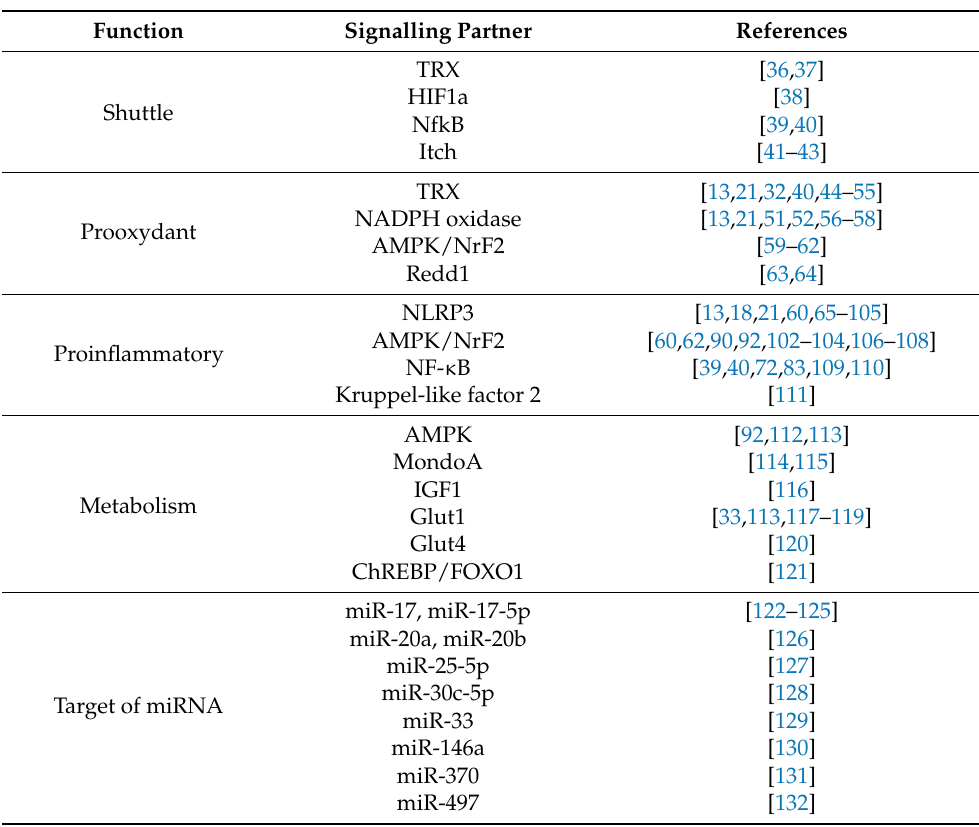
Table 1. The multiple signaling partners of TXNIP and pleiotropic effects. Function Signalling